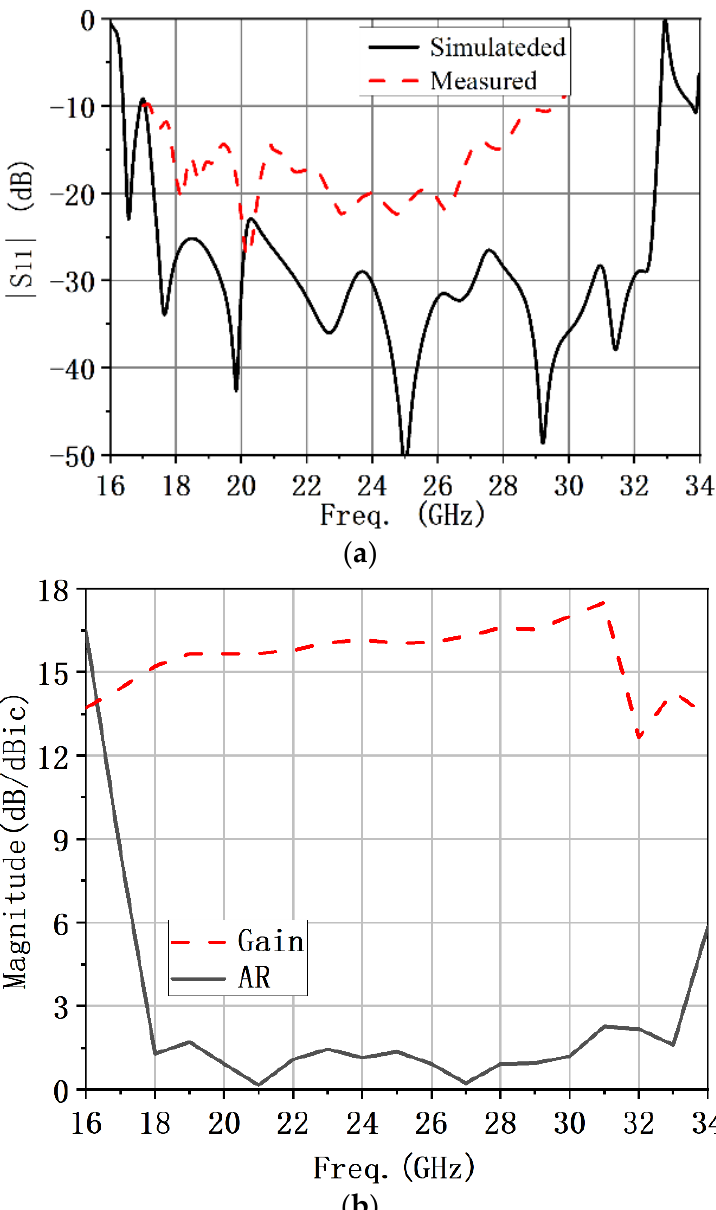
Figure 17. Photographs of the fabricated CP conical corrugated horn antenna.